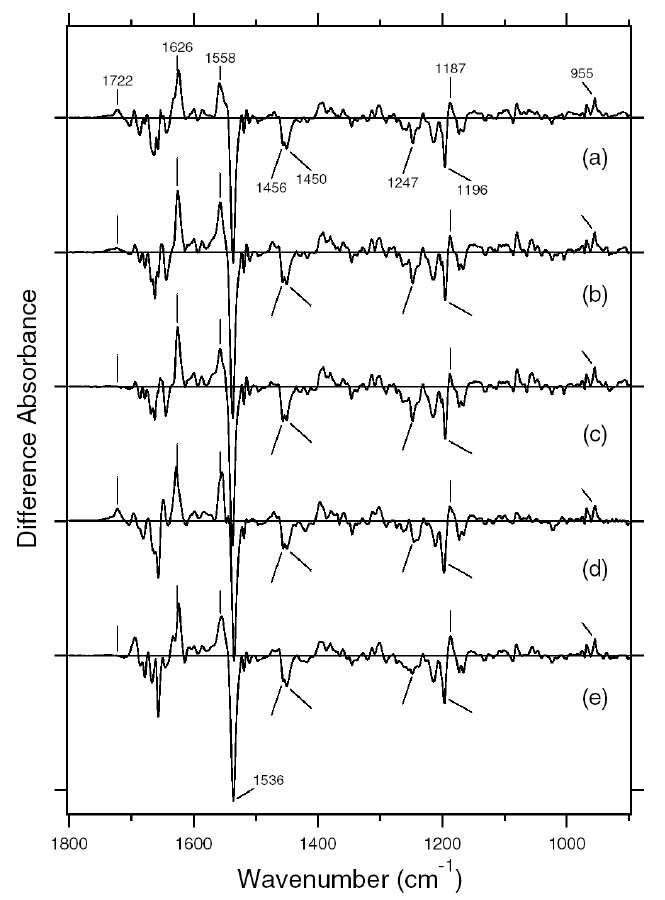
Figure 35. The ASR minus ASR infrared spectra of the wild type at pH 5 (a), pH 7 (b), L and pH 9 (c), D217N at pH 5 (d) and E36Q at pH 5 (e) in the 1,800–900 cm -1 region. The spectra are measured at 170 K upon hydration with H O. One division of the y-axis 2 corresponds to 0.009 absorbance units. This figure is reprinted with permission from Kawanabe et al [77]. Copyright 2008 American Chemical